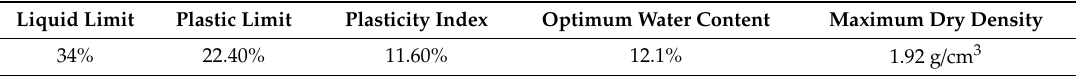
Table 1. Typical physical properties of silty clay.